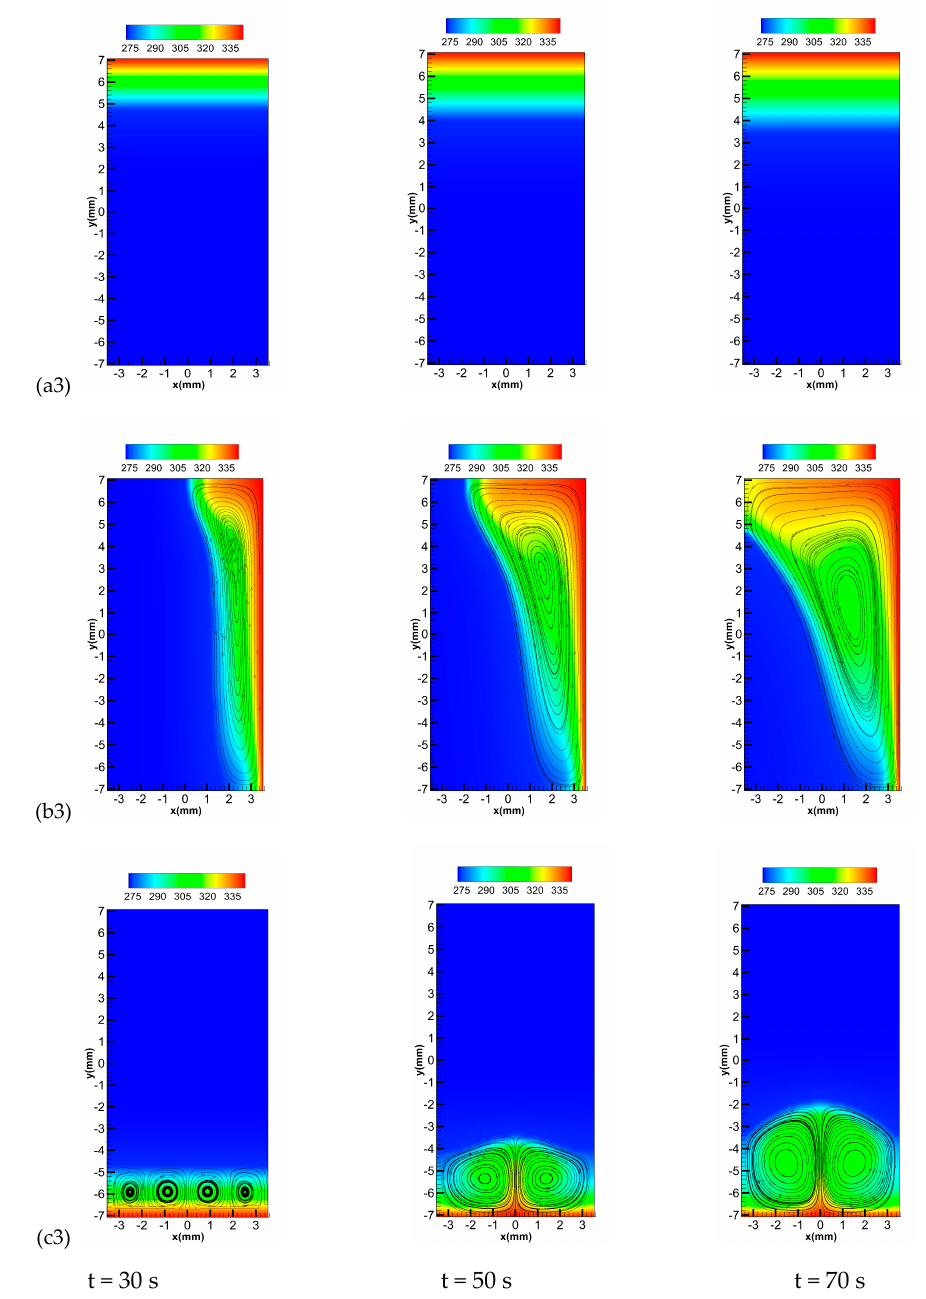
Figure 7. Temperature contours with streamlines at t = 30 s, 50 s, 70 s. ( a1 )–( a3 ) Heating the top side; ( b1 )–( b3 ) heating the right side; ( c1 )–( c3) heating the bottom side. ( b1 )–( b3 ) heating the right side; ( c1 )–( c3) heating the bottom